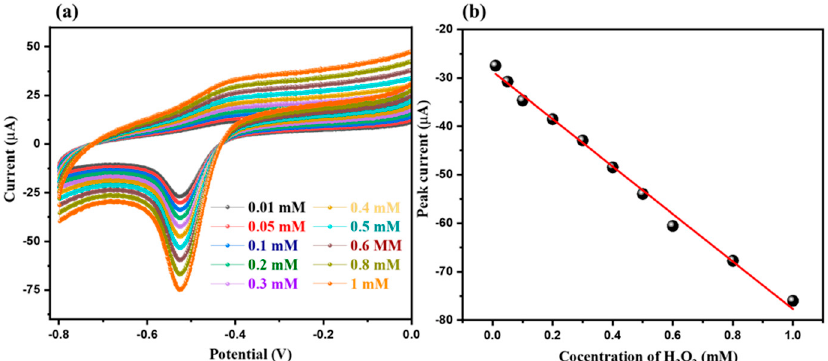
Figure 7. The CV curves of SPCE (red) and N-rGO/SPCE (black) in the presence of 0.01 mM H 2 O 2 in 0.1 M PBS of pH 7.0 at a scan rate of 50 mVs − 1 .